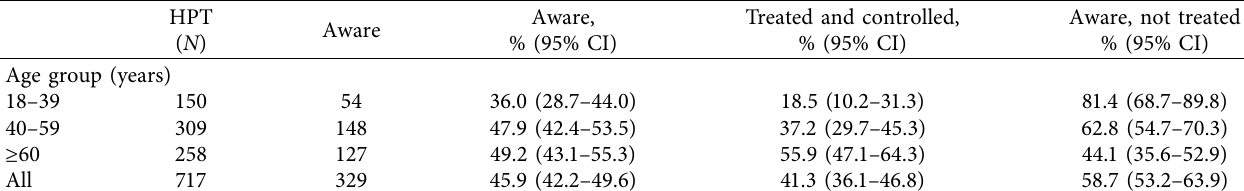
Table 4: Awareness, treatment, and control of hypertension among the study